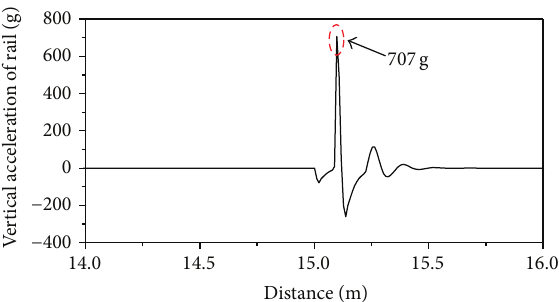
Figure 15: Vertical acceleration of rail in time domain.